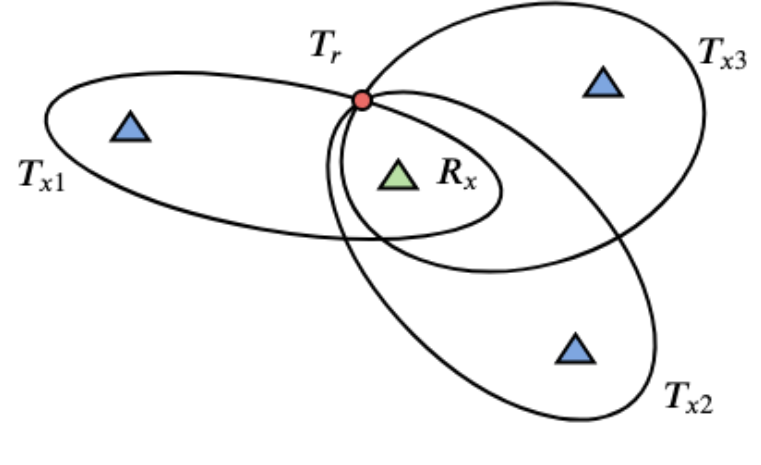
Figure 6. A concept of target localisation as the intersection of ellipses determined by bistatic distances for three different transmitter-receiver